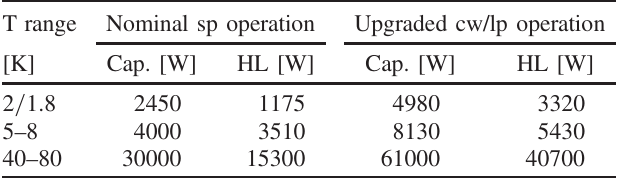
TABLE II. Capacity and HL of cryogenic